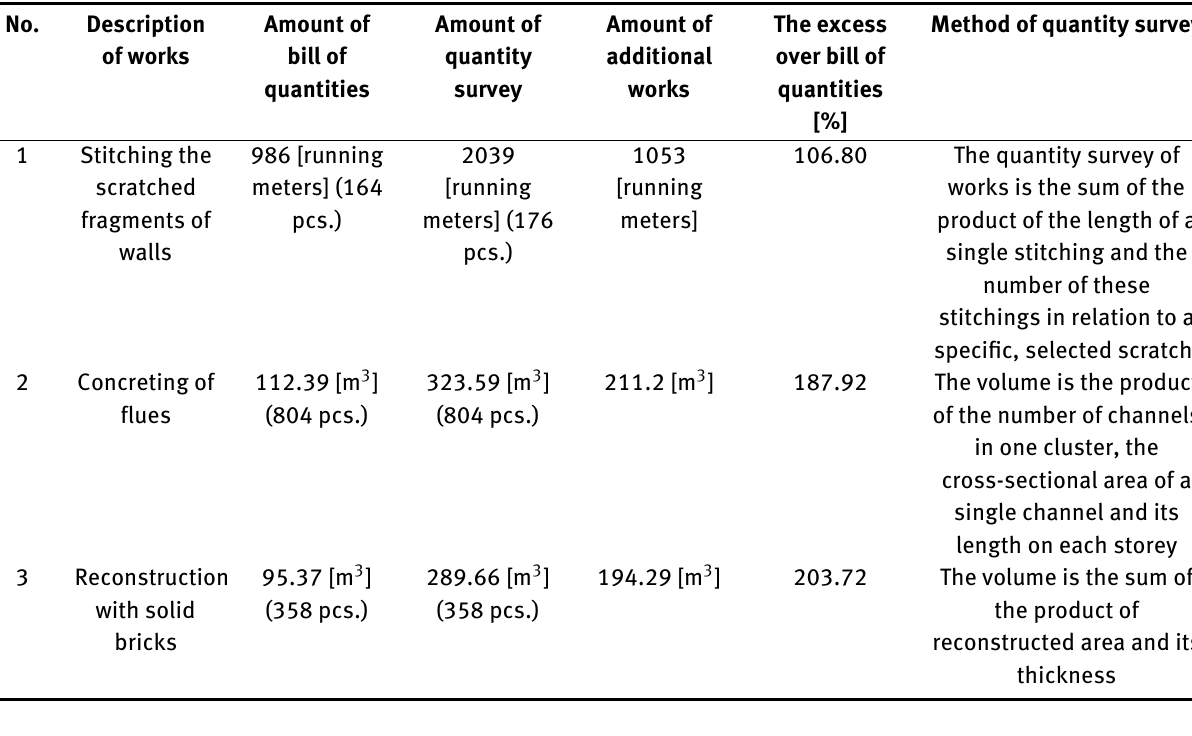
Amount of bill of quantities